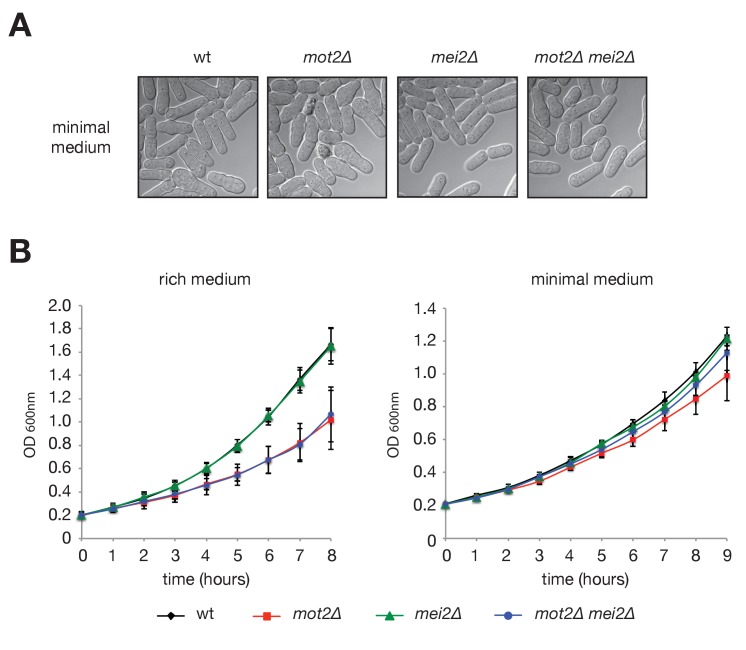
Phenotypic characterization of the mot2∆ mutant.(A) Phase contrast images of exponentially growing wild type, mot2∆, mei2∆ and mot2∆ mei2∆ cells cultured in minimal medium (EMM0.5X). (B) Cells of the indicated genotypes were grown in rich (YE; left panel) and minimal (EMM0.5X; right panel) media, and the optical density (OD600nm) was measured over time.